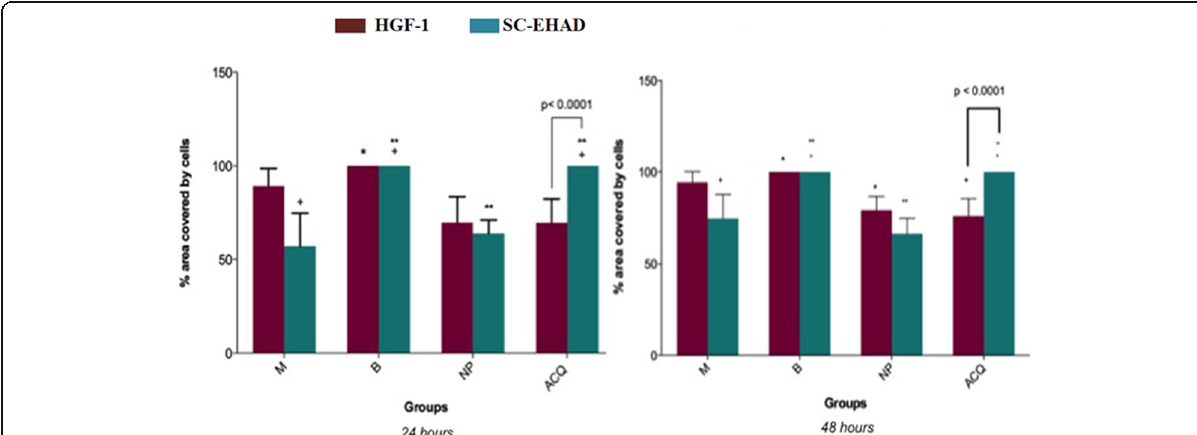
Fig. 5 Percentage area of the disks covered by cells (mean ± standard deviation) at 24 and 48 h, according to groups. Equal symbols in columns HGF-1 represent *significant differences between groups B and NP, ACQ, and M ( p < 0.01; Kruskal-Wallis post hoc Dunn). Equal symbols in columns SC-EHAD represent + significant differences between M and groups B and ACQ ( p < 0.001; Kruskal-Wallis post hoc Dunn); ** significant differences between NP and groups B and ACQ ( p < 0.001; Kruskal-Wallis post hoc Dunn)